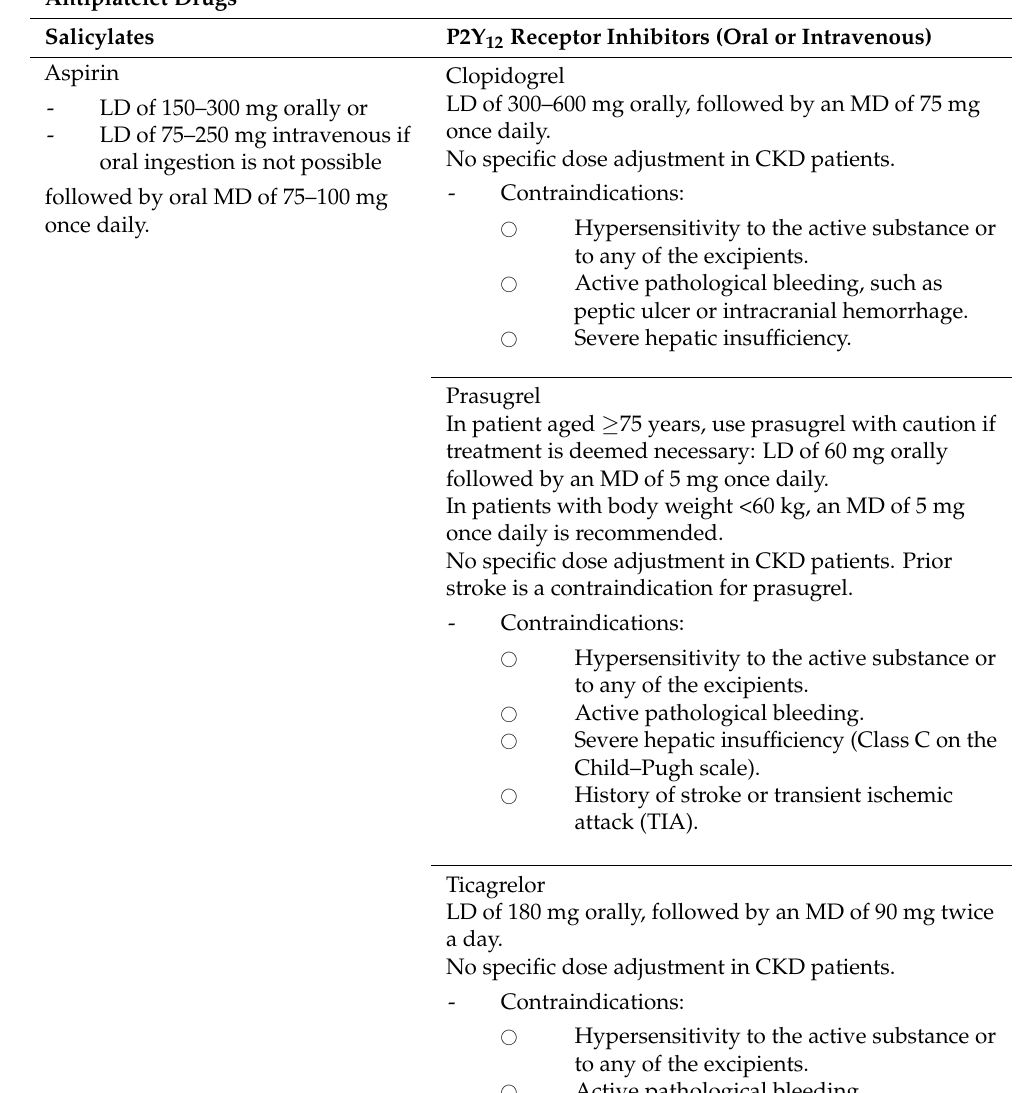
Table 2. Type and dosing regimen of antiplatelet agents in acute coronary syndrome. Antiplatelet